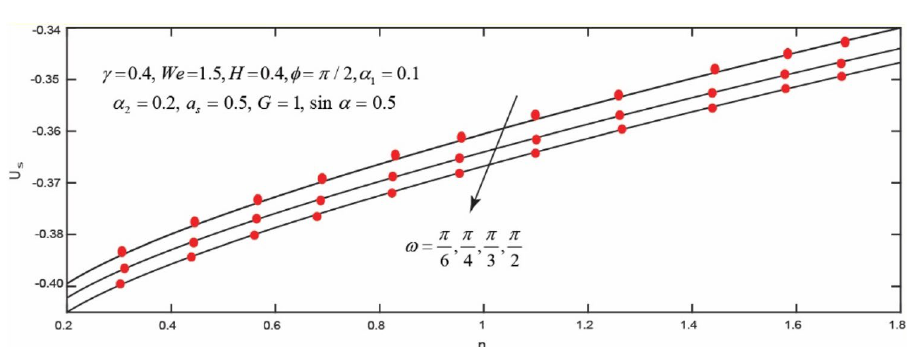
Figure 3. Impact of inclined angle ω on organisms swimming speed.